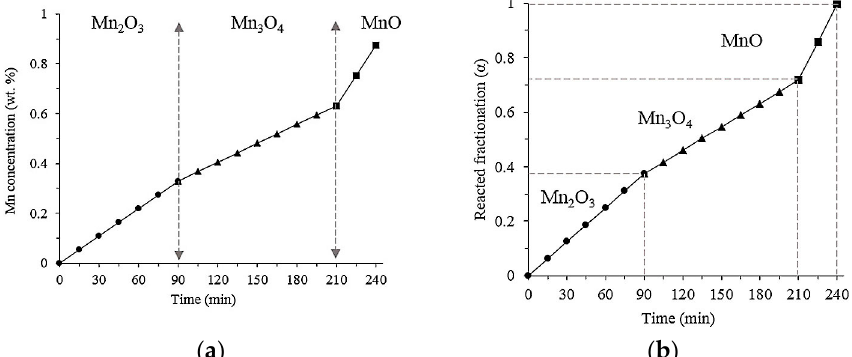
Figure 7. Manganese concentration as a function of time ( a ) and a fraction reacted to time ( b ), simulating the oxidation states present in the aluminothermic reduction process (Mn 2 O 3 , Mn 3 O 4 , and MnO).